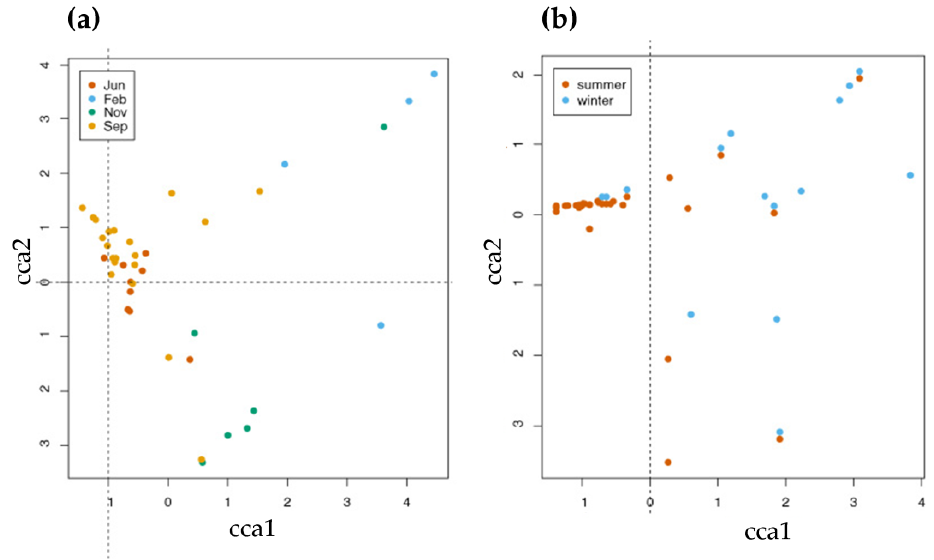
Figure 5. CCA ordination diagrams. As an environmental factor: ( a ) sampling months; ( b ) sampling season.